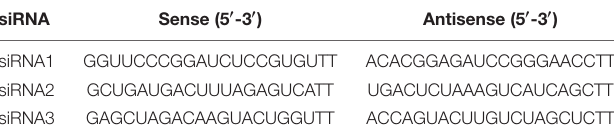
TABLE 1 | The sequences of 3 siRNA against KRT18 mRNA sequence.